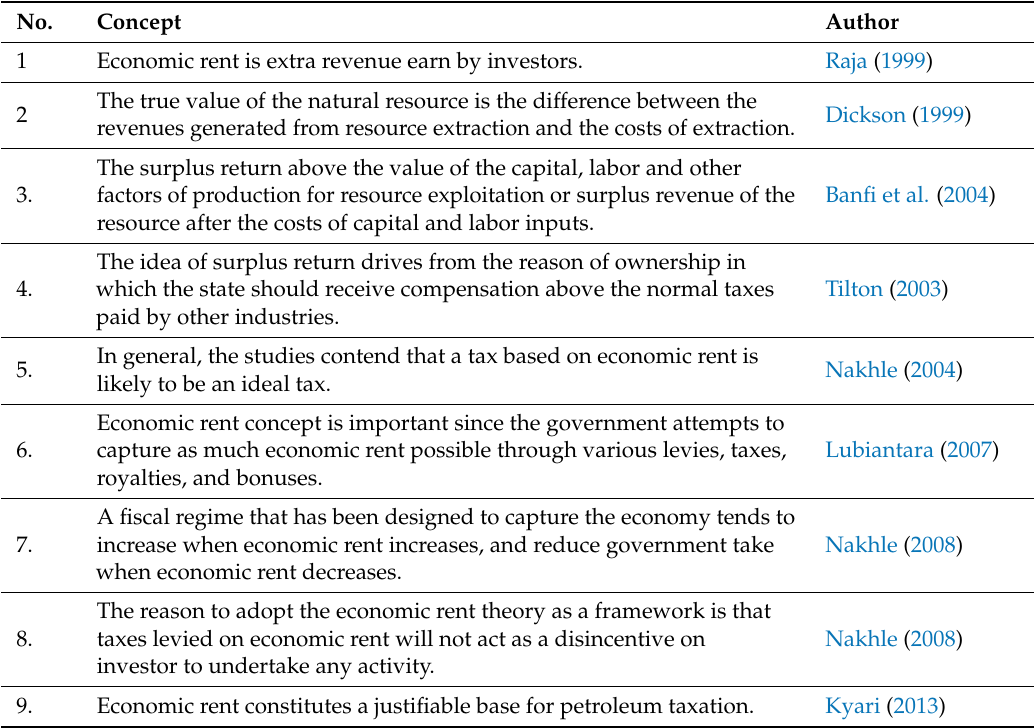
Table 1. Major Concept of Economic